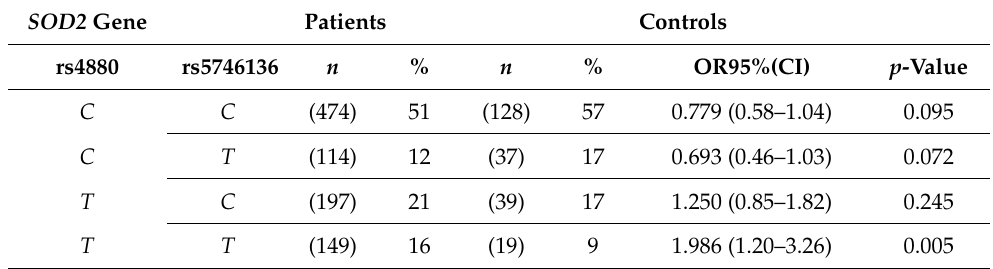
Table 6. Haplotype frequency of the rs4880, and rs5746136 variants of SOD2 in BC patients and controls. SOD2 Gene Patients Controls